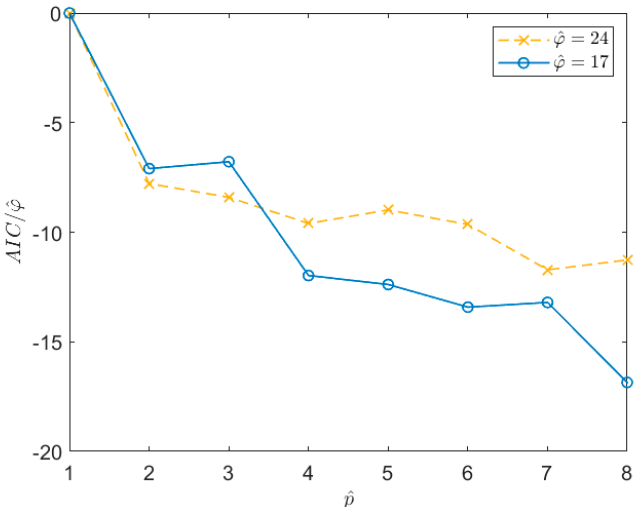
Figure 9. Trend of the AIC index, normalized with respect to the number of the auto − covariance samples used for the estimation procedure. The curves refer to two different time series of Type 1 signals in Table 1 sampled at 1 Hz for 10 min.